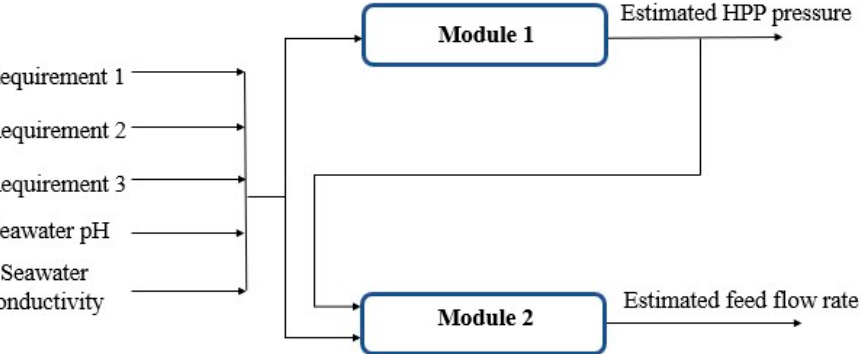
Figure 3. Block diagram of the two first modules of the system, where ML techniques were applied.